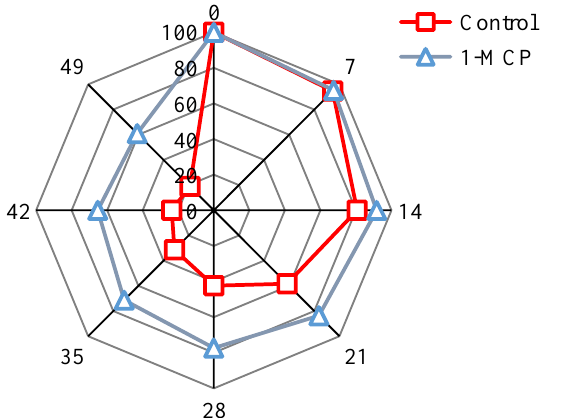
Figure 1. The sensory evaluation scores of ’Dianhong’ rose petals treated with 1 − MCP at different storage periods.